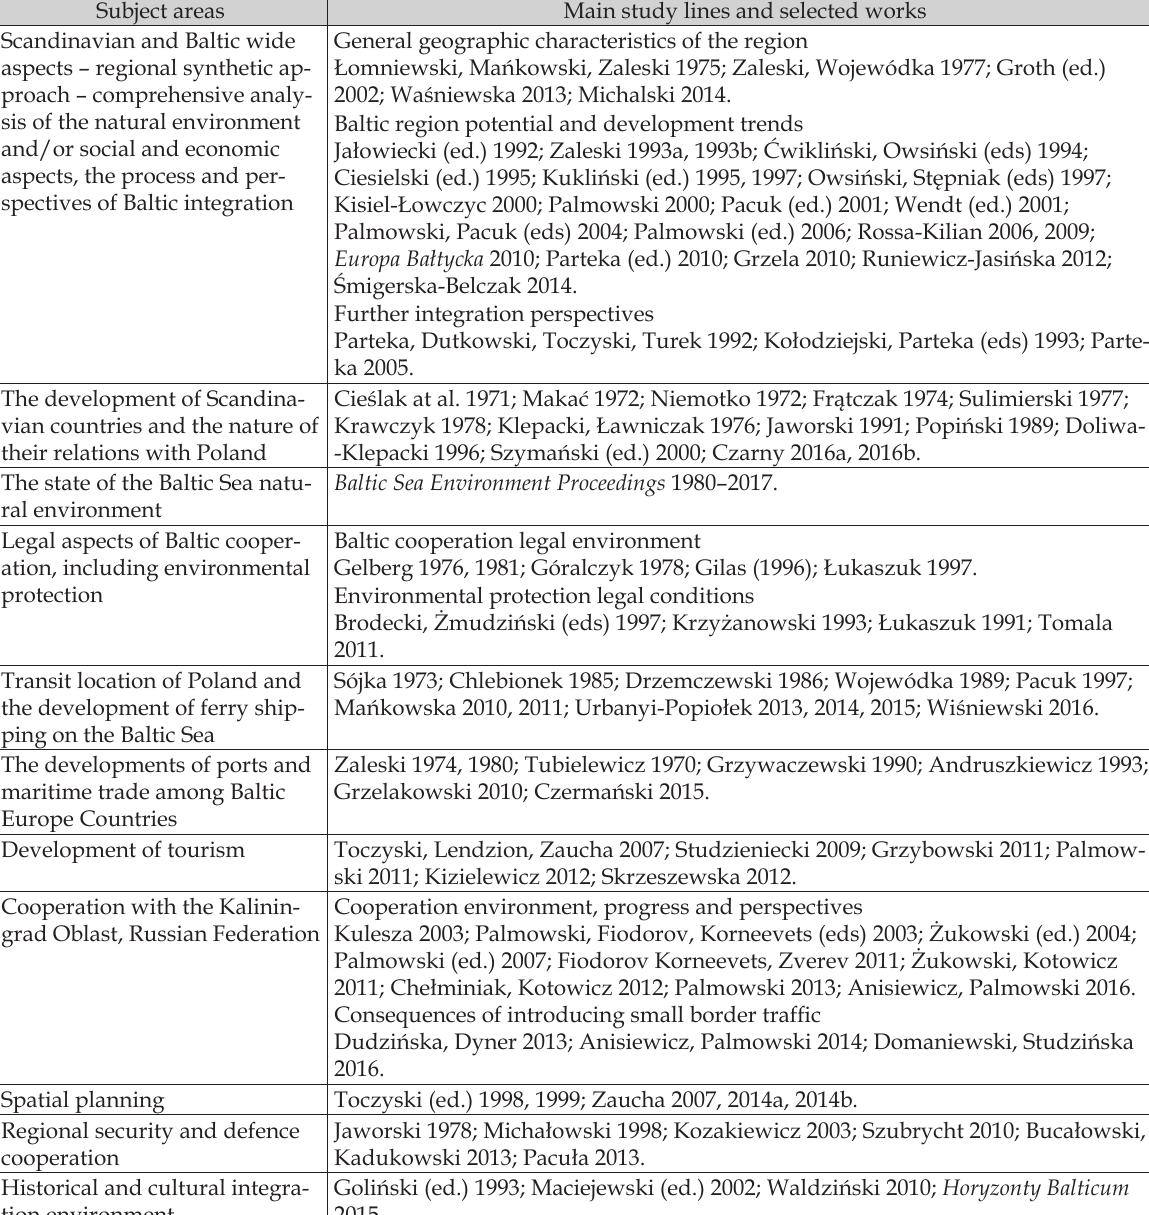
Table 2. Baltic integrations research themes in the years 1971–2016 and selected subject literature. Main study lines and selected